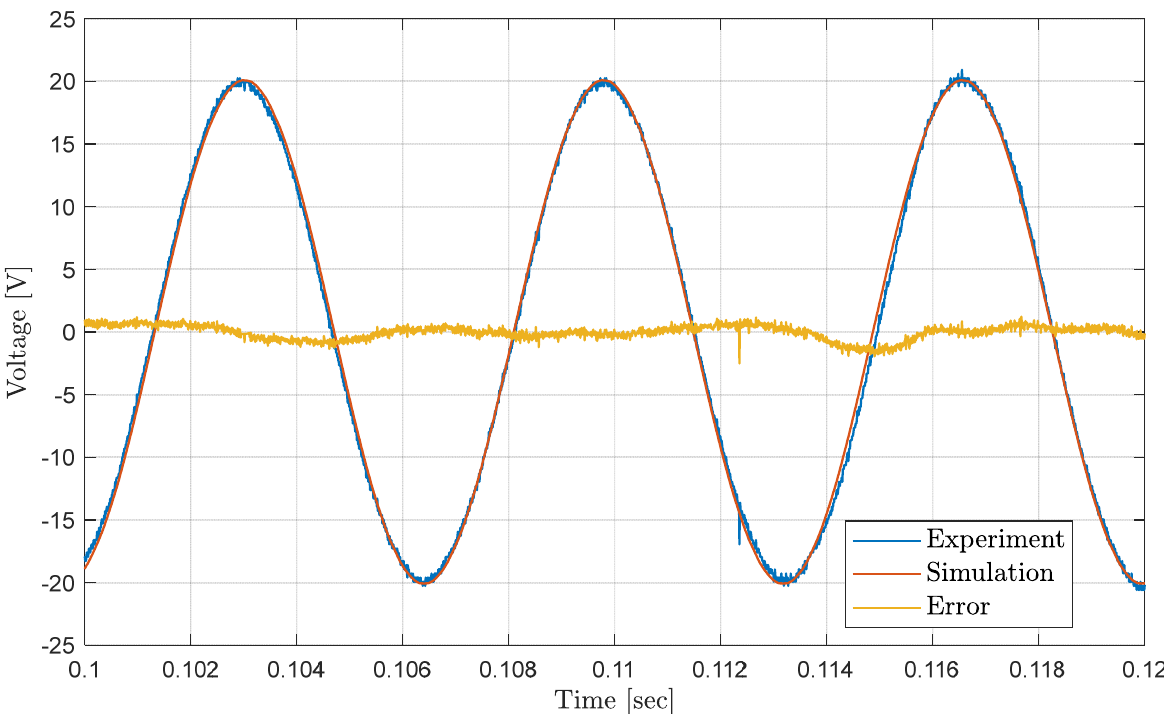
Figure 12. Response to Test 3 (open loop, open phases, disengaged brakes, motor dragged at 80 rad/s, phase-to-phase BEMF measured).